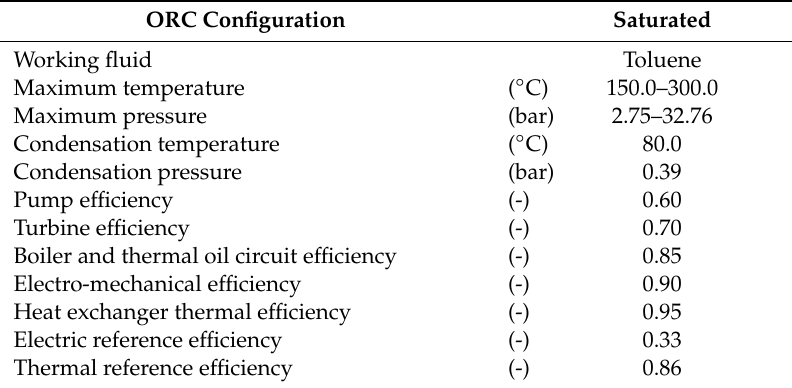
Table 1. ORC operating conditions and main assumptions.